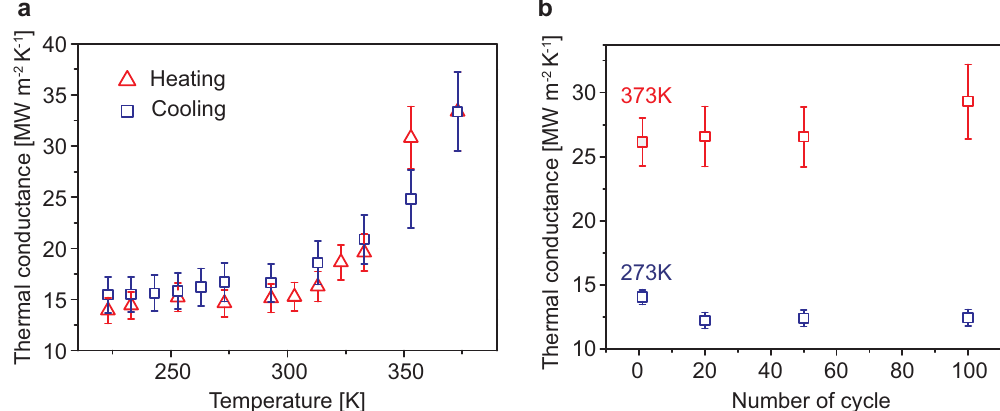
Figure 4. ( a ) Thermal conductance versus temperature plot of “VO 2 + NG” Device1 during heating and cooling. ( b ) Thermal conductance switching of the “VO 2 + NG” Device1 from ( a ) during sequential cooling and heating between 373 K and 273 K, corresponding to alternation between the metal and insulator phases of VO 2 . The ramp rate of temperature was 5 K min − 1 for both heating and